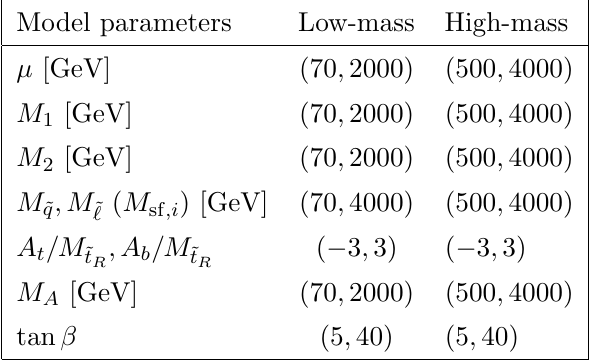
Table 5 . Parameter ranges of the scans performed. The range for M sf ;i applies to all combinations of independent sfermion mass parameters for the four